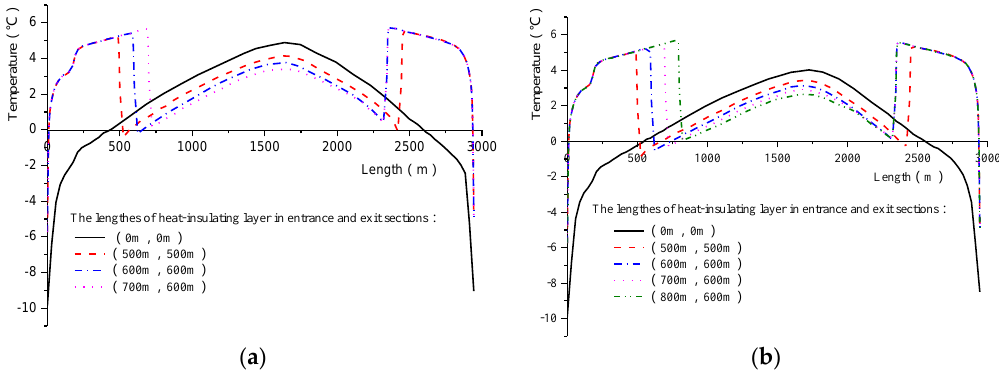
Figure 16. Average temperature in December of the surface of the tunnel secondary lining in the longitudinal direction (with different lengths of the heat-insulating layer): ( a ) under 5 m/s mechanical ventilation condition and ( b ) under mechanical 6 m/s ventilation condition.